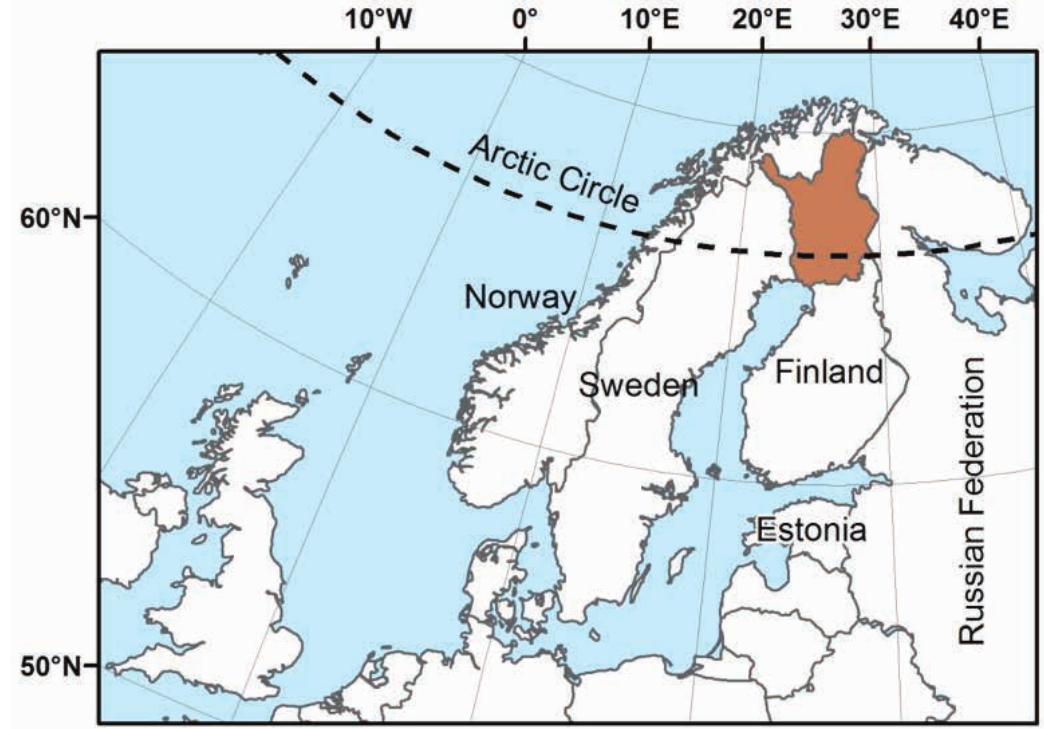
Figure 1: Location of Lapland, the northernmost region of Finland, is marked in